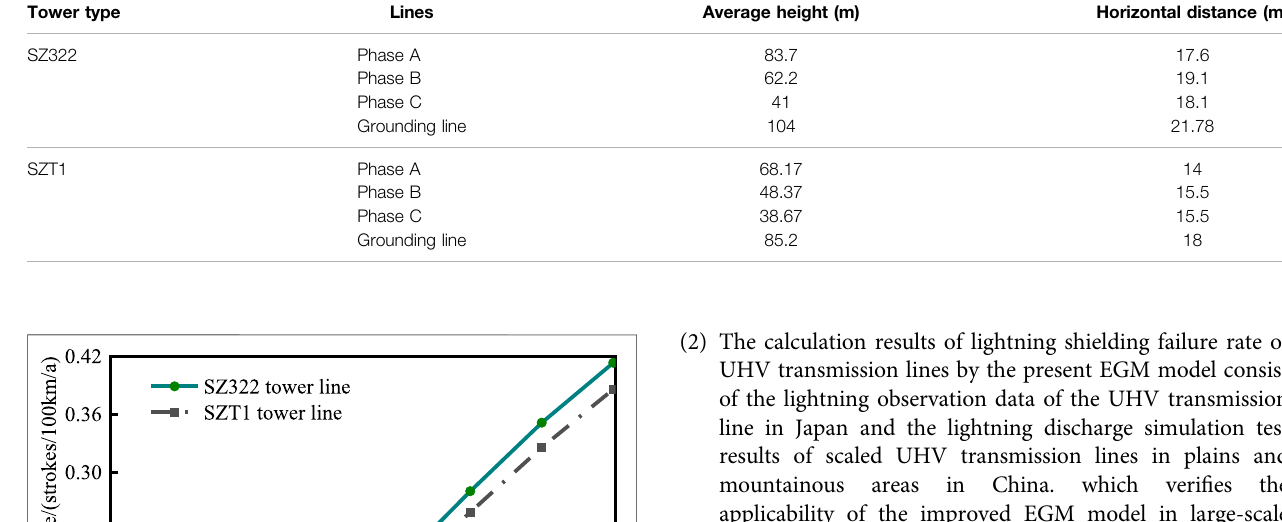
TABLE 2 | Practical size parameters of SZT1 and SZ322 tower lines. Tower type